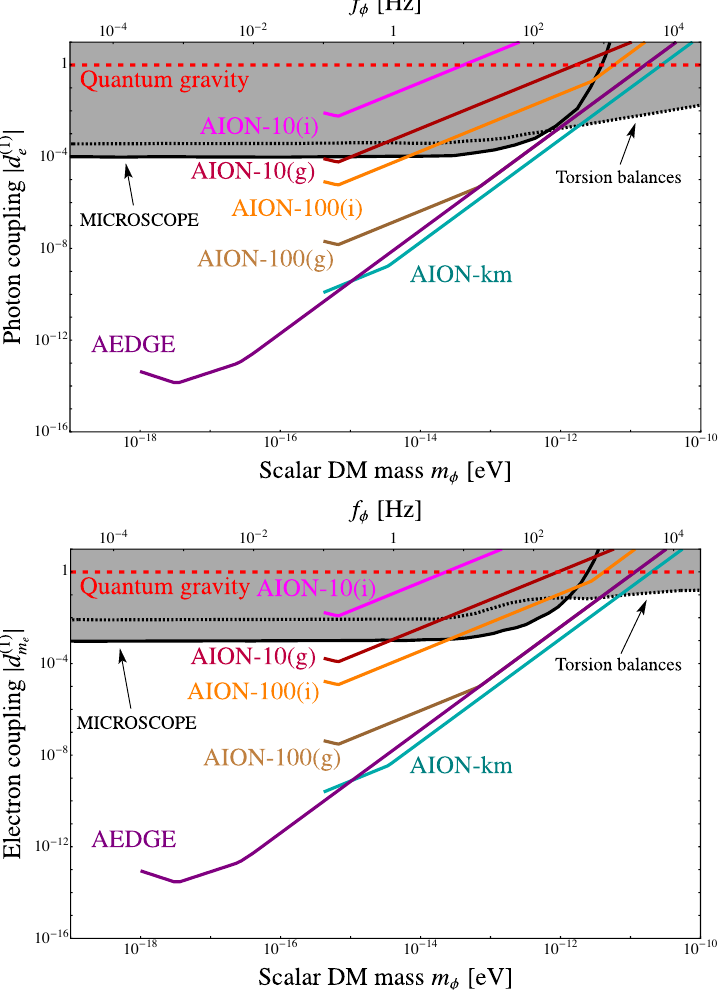
( 1 ) ( 1 ) ( 1 ) ( 1 ) Figure 1. Bounds on the parameters d , d as a function of the mass of the scalar field. Quantum e , d m e as a function of the mass of the scalar field. e m e ( 1 ) ( 1 ) , d 1, closing all of the parameter space accessible to atom interferometers. e m e ∼